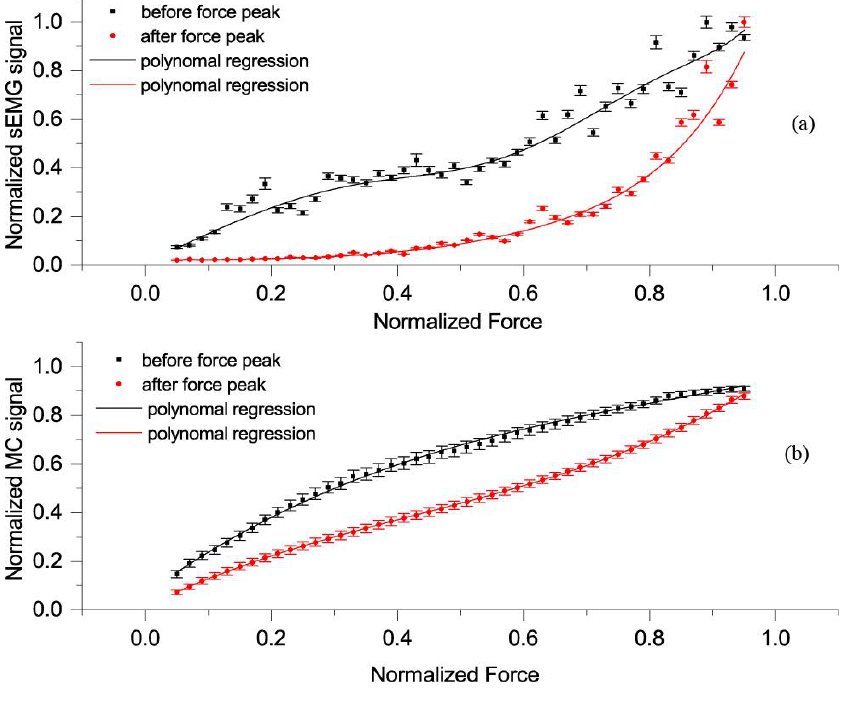
Figure 6. ( a ) Each point on curves is the average of all records of the mean normalized sEMG, obtained when F was within 2% of each chosen force value (0.02, 0.4...to 0.98 at D elbow angle 15°) while the force was rising ( i.e ., before the peak, black colour) or while force was falling ( i.e ., after the peak, red colour). Bars show SEM, and line is polynomial regression of the relationship between F and F , before the peak (adjusted R 2 = 0.96) MC D and red line after the peak (adjusted R 2 = 0.96); ( b ) Each point on the curves is the average of all records of the mean normalized F , obtained when F was within 2% of each MC D chosen force value (0.02, 0.4...to 0.98 at elbow angle 15°) while the force was rising ( i.e ., before the peak, black colour) or while force was falling ( i.e ., after the peak, red colour). Bars show SEM, and line is polynomial regression of the relationship between F and F , MC D before the peak (adjusted R 2 = 0.99) and red line after the peak (adjusted R 2 =